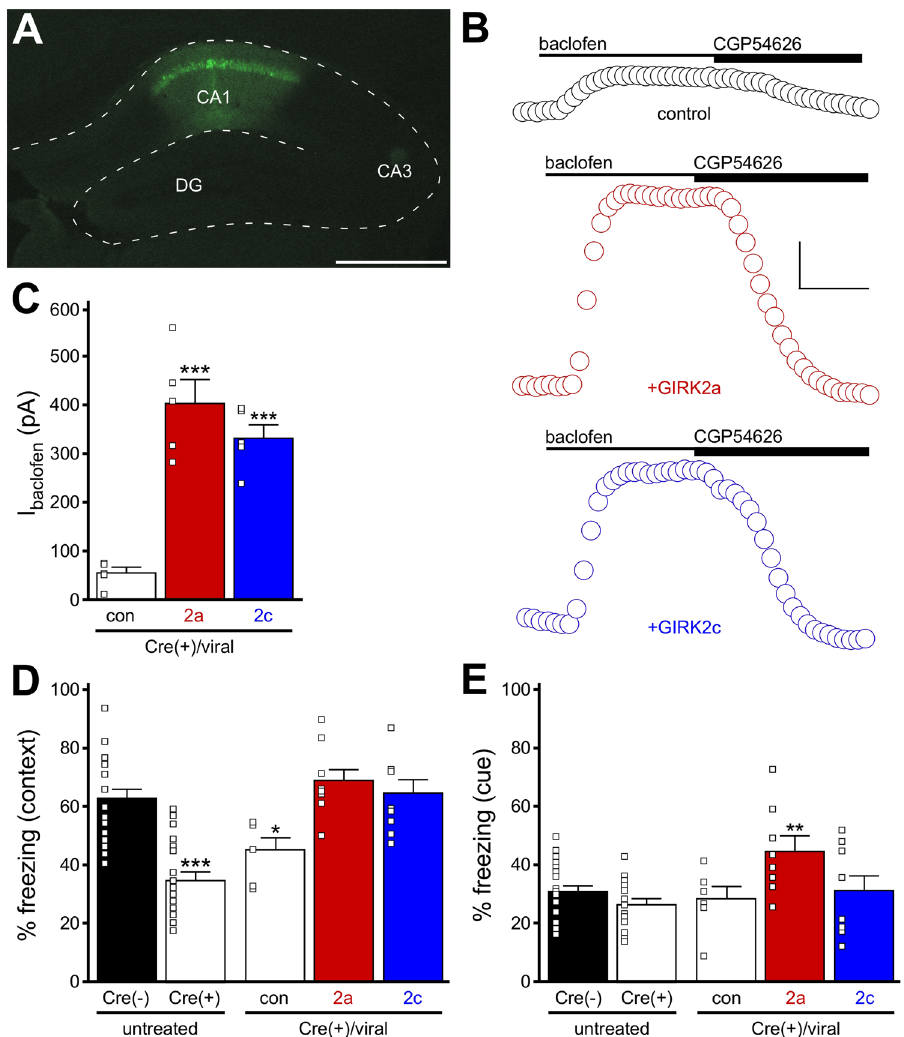
Figure 7. Fear learning in CaMKIICre( + ): Girk2 fl/fl mice expressing GIRK2a or GIRK2c. ( A ) EGFP expression in the dorsal CA1 of a CaMKIICre( + ): Girk2 fl/fl mouse, 2 wk after infusion of the AAV8-CaMKII α - DIO-GIRK2a-IRES-EGFP virus. Scale bar: 500 microns. ( B ) Representative somato-dendritic currents (V hold = − 60 mV) evoked by baclofen (200 μ M) and reversed by the GABA B R antagonist CGP54626 (2 μ M) in dorsal CA1 pyramidal neurons from CaMKIICre( + ): Girk2 fl/fl mice, 2 wk after infusion of Cre-dependent control (con, mCherry), GIRK2a, or GIRK2c virus. Scale: 100 pA/100 s. ( C ) Summary of baclofen-induced currents in dorsal CA1 pyramidal neurons from CaMKIICre( + ): Girk2 fl/fl mice, 2 wk after infusion of Cre- dependent control (con, mCherry), GIRK2a, or GIRK2c virus (F 2,11 = 24.3, P < 0.001; n = 4–5/group). Symbols: *** P < 0.001 vs. control. ( D ) Contextual fear learning in untreated CaMKIICre( − ): Girk2 fl/fl mice and CaMKIICre( + ): Girk2 fl/fl mice, and in CaMKIICre( + ): Girk2 fl/fl mice following infusion of Cre-dependent control (con, mCherry), GIRK2a, or GIRK2c virus in the dorsal CA1 (F 4,55 = 14.7, P < 0.001; n = 6–23/ group). Symbols: * , *** P < 0.05 and 0.001, respectively, vs. Cre( − ). ( E ) Cue fear learning in untreated CaMKIICre( − ): Girk2 fl/fl mice and CaMKIICre( + ): Girk2 fl/fl mice, and in CaMKIICre( + ): Girk2 fl/fl mice following infusion of Cre-dependent control (con, mCherry), GIRK2a, or GIRK2c virus in the dorsal CA1 (F 4,55 = 4.0, P < 0.01; n = 6–23/group). Symbols: ** P < 0.01 vs. Cre( −